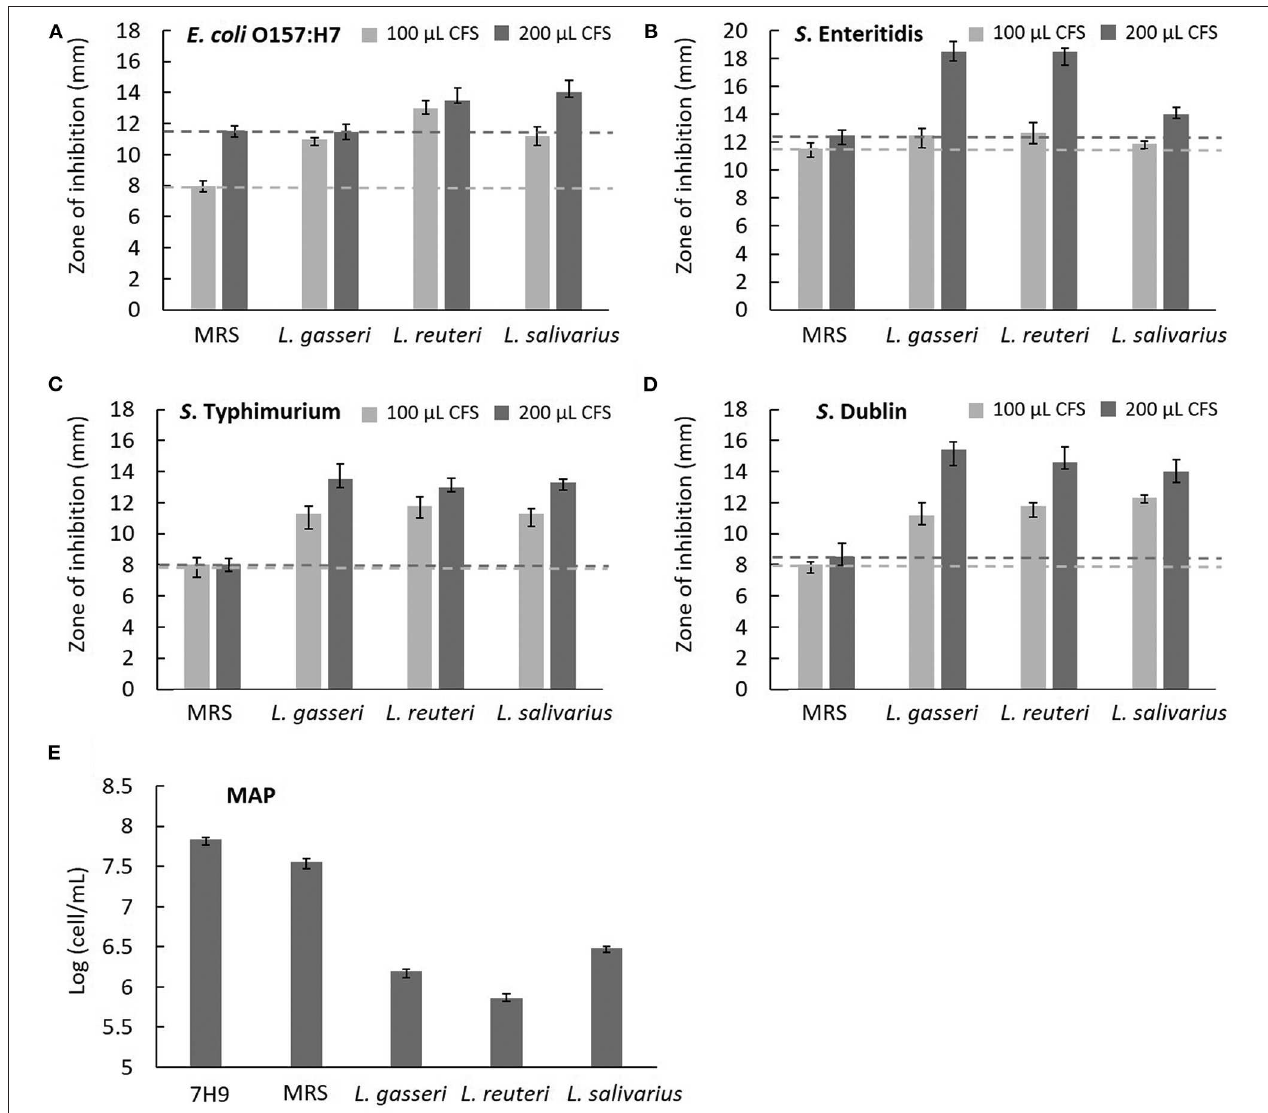
FIGURE 5 | Characterization of the antimicrobial activity of three isolated Lactobacillus strains. The cell-free supernatants (CFSs) of L. gasseri , L. reuteri , L. salivarius , and acidified MRS (negative control) in the volume of 100 µ L (light gray bar) and 200 µ L (dark gray bar) were tested for the inhibition of intestinal pathogens of bovine, including (A) E. coli O157:H7, (B) S. enteritidis , (C) S. typhimurium , and (D) S. Dublin using Oxford Cup methods. The horizontal reference lines (light gray and dark gray dotted lines) represent the ZOI of MRS broth at 100 and 200 µ L, respectively. (E) The CFS of three isolates (0.5mL) was tested for the inhibition of MAP growth.